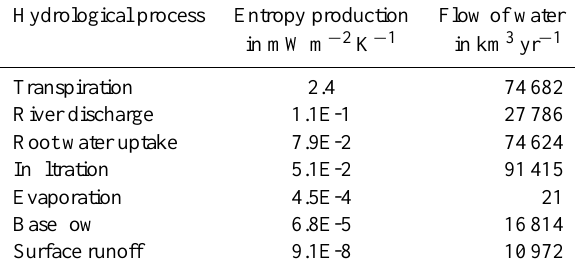
Table 1. Global land surface mean values of entropy production averaged over 10 yr of simulation with the JESSY/SIMBA model which is parametrised according to